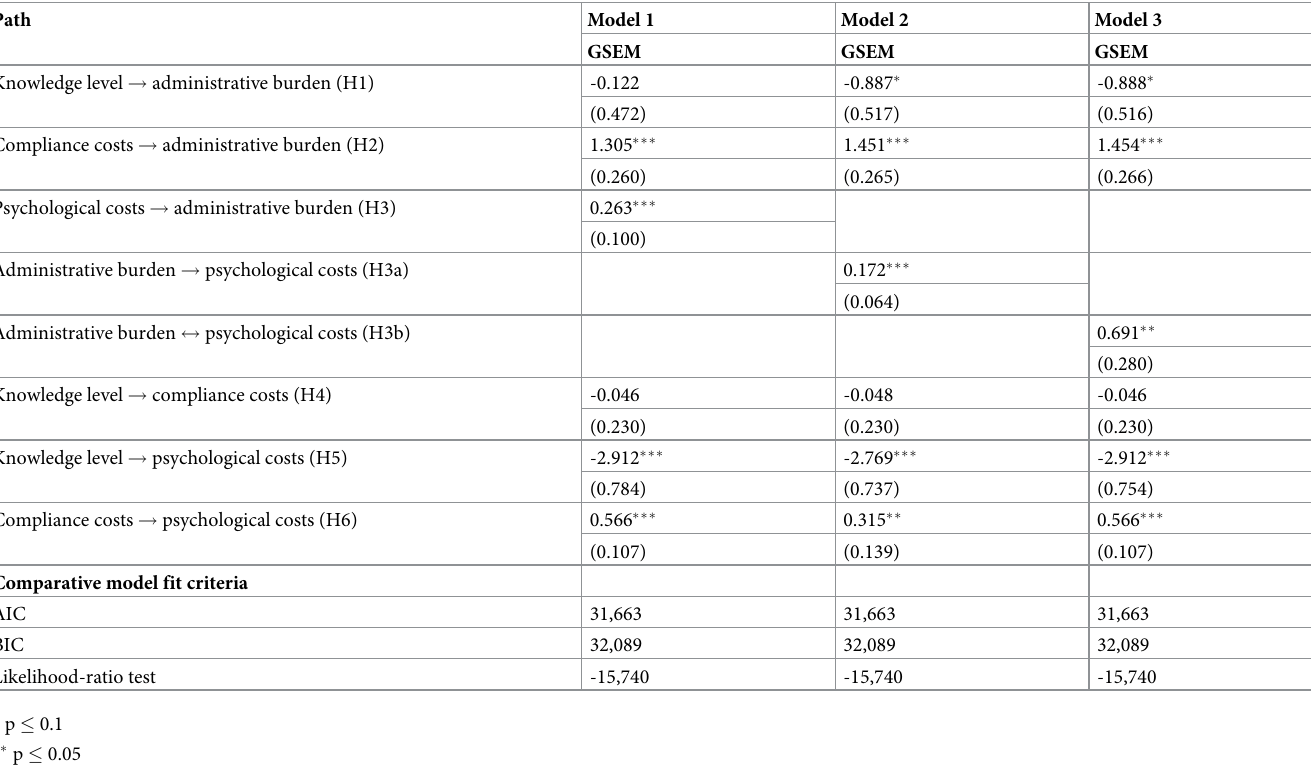
Table 3. Direct effects of the (causal) structural model (unstandardized